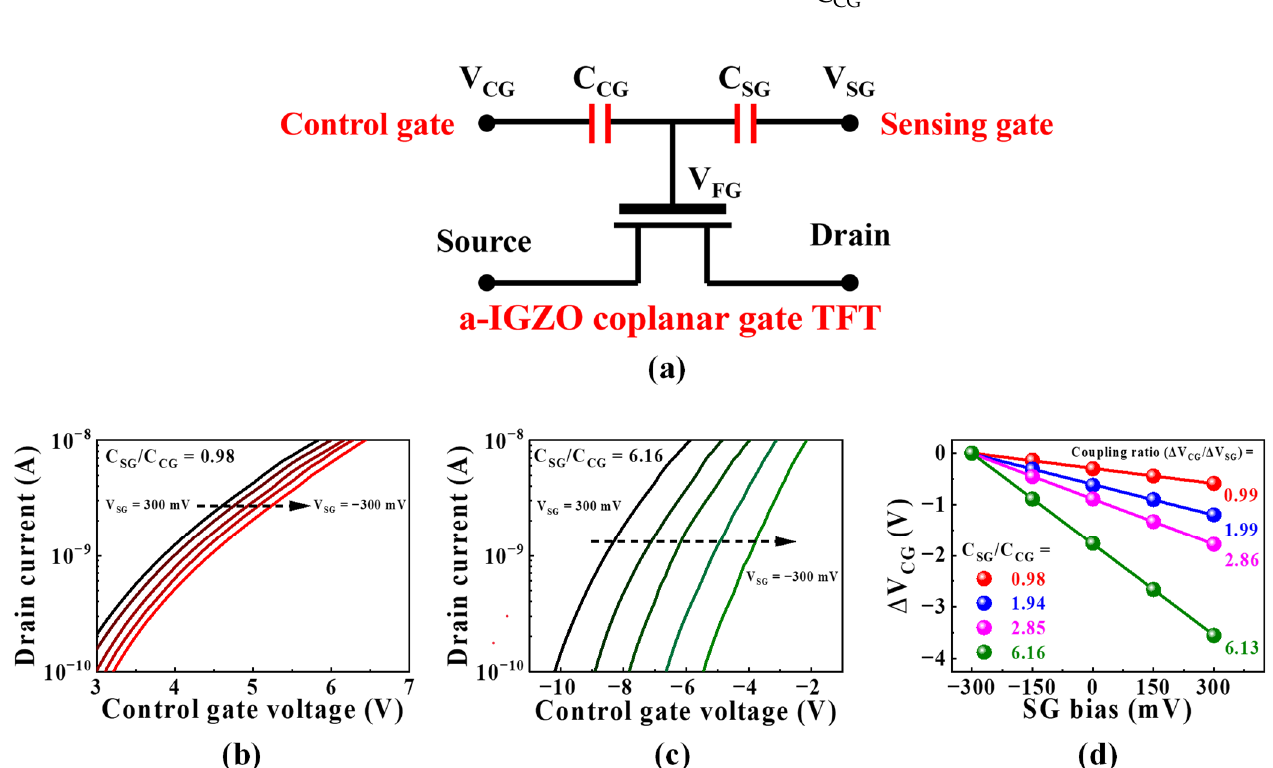
Figure 4. ( a ) Simplified schematic illustration of the electrical equivalent circuit of an a-IGZO coplanar dual-gate TFT. Shifts in the transfer characteristic curve for amplification factor of ( b ) 0.98 and ( c ) 6.16 when SG bias (V SG ) is varied from +300 mV to − 300 mV at intervals of 150 mV. ( d ) Δ V CG / Δ V SG for various values of C SG /C CG obtained at I Read = 1 nA.